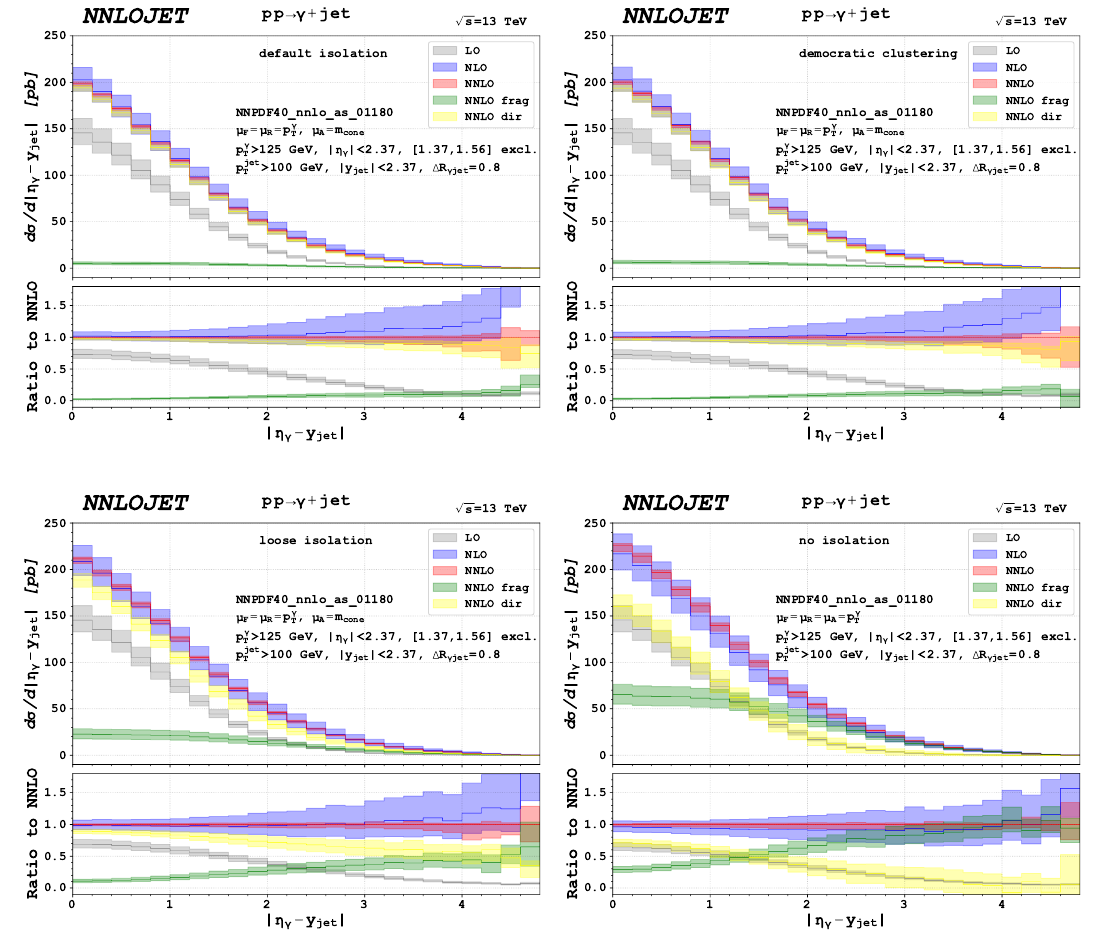
Figure 15. Decomposition of the cross section differential in the rapidity difference between the photon and the jet. Results obtained with the default isolation, a loose isolation, democratic clustering and without isolation are